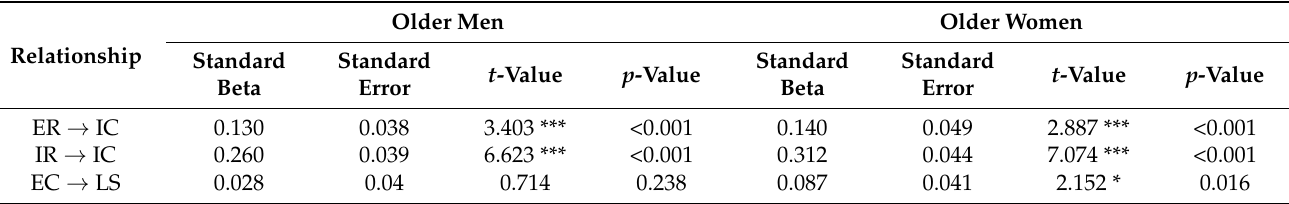
Table 7. Model comparison for significant moderating relationships by